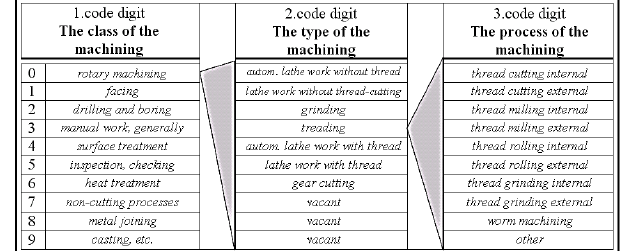
Figure 7. The example of the Structure of operation